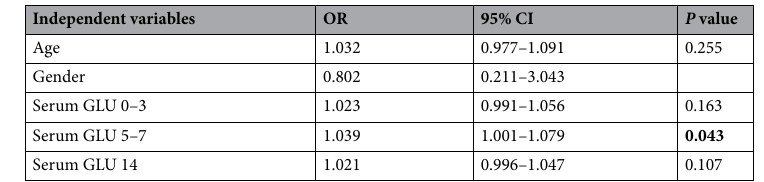
Table 3. Odds ratio (OR) of the presence of neurological deficits in 45 SAH patients at hospital discharge. Age, gender, and serum glutamate levels as predictors. OR, odds ratio; CI, confidence interval; SGLU, serum glutamate. Significant values are in